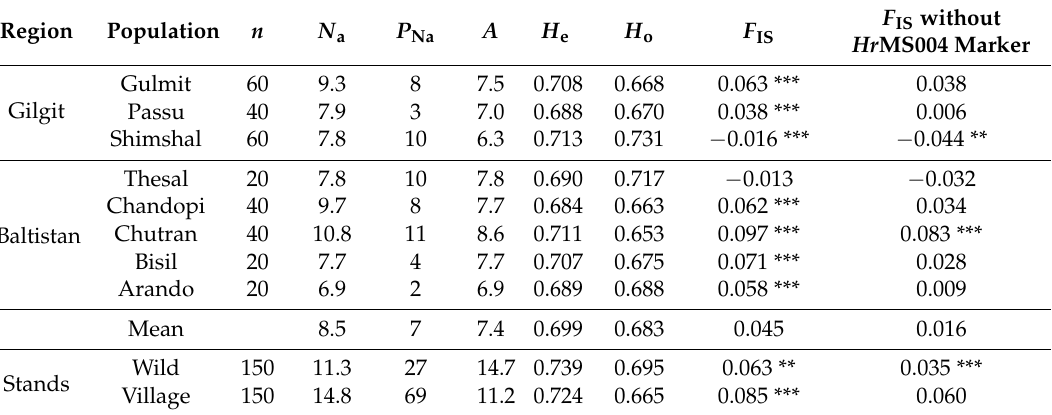
Table 6. Genetic diversity and differentiation parameters of eight sea buckthorn populations studied in the Gilgit and Baltistan regions, northern